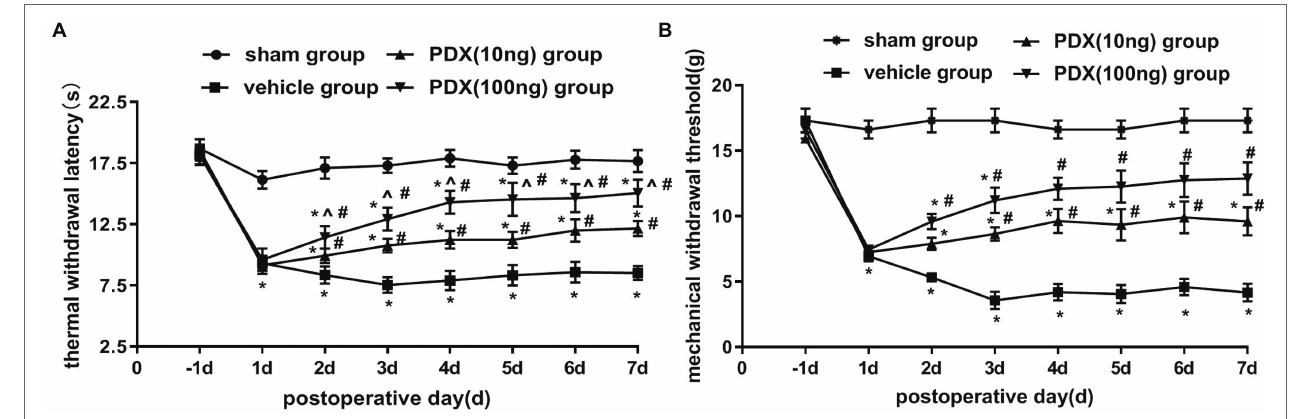
FIGURE 1 | Protective effects of protectin DX (PDX) in lumbar radicular pain (LRP) rat models of non-compressive lumbar disc herniation (NCLDH; n = 9/group). (A) Thermal withdrawal latency (TWL) was evaluated with BME-410A thermal dolorimeter, (B) mechanical withdrawal threshold (MWT) was detected by applying von Frey up-down testing. PDX (10 ng or 100 ng) prominently meliorated the TWL and MWT of LRP rat models. Two-way ANOVA was used for comparisons among groups followed by Turkey’s multiple comparison test (log10 transformation for the statistical analysis of the MWT); Data are presented as the mean ± SEM (* p < 0.05